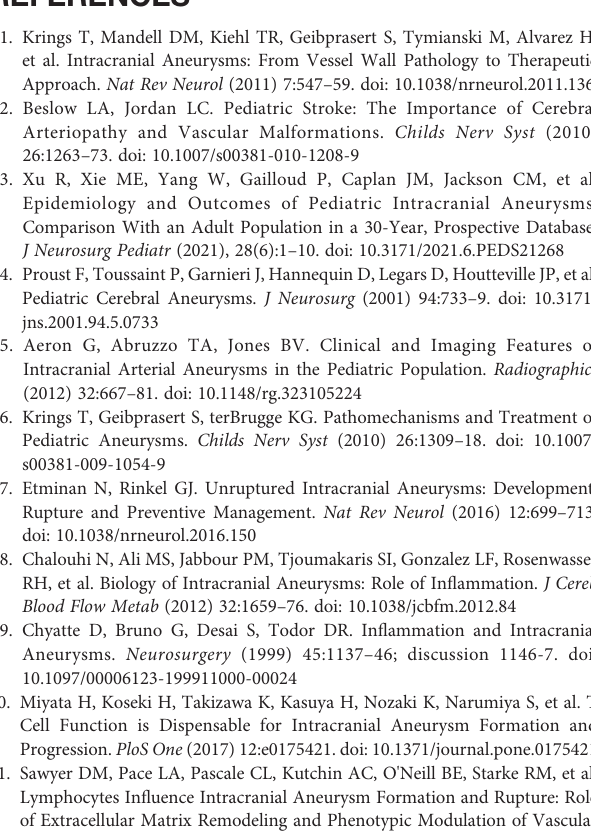
Supplementary Figure 2 | (A) Histograms ofthemarkerexpressionvalues (surface and intracellular differentiation markers analysed ex vivo ) that were used to distinguish cell clusters. Clusters were colored according to the tissue of origin: IA wall (red), PBMCs (green). (B) UMAPs of all analysed markers (as indicated). Blue denotes low, green intermediate and red high expression. (C) Percentages of the nine cell clusters. Supplementary Figure 3 | The temporal order of differentiating cells was inferred by DiffusionMap. DiffusionMap, colored by sample of origin (A) and clusters (B) , showhigherproximityofIAwallT-cellstocirculatingmemoryTcellsascomparedto naïve cells. A general differentiation pattern from naïve phenotypes to memory and TRM in CD4+, CD8+ and DN T-cells can be observed. Supplementary Figure 4 | Gating Strategy used to analyse T cell compartment for CD4+, CD8+ and DN T-cell subsets. Supplementary Figure 5 | (A) CD127 versus CCR7 expression of gated Th1 (CXCR3+ CCR6-), Th1/17 (CXCR3+ CCR6+) and Th17 (CCR6+) were analysed to identify central memory cells (CCR7+CD127+), effector memory (CCR7- CD127+) and effector-like (CD127- CCR7-) cells. (B) To assess the presence of CD27 +CCR6- Tr1-like cells the expression of CD27 and CCR6 was analysed on gated CD4+ CD25- CD127- CCR5+ T-cells. (C) Gating Strategy used to analyse CD4+ effector-like T-cells (CD127 lo FOXP3-). Supplementary Figure 6 | (A) Histograms of the marker (cytokines and differentiation markers) expression values were used to distinguish cell clusters followingbriefpolyclonal stimulation.Clusterswerecoloredaccordingtothesample of origin: IA_WALL (red), PT_PBMCs and IA_WALL (yellow), PBMCs (blue) and ALL (shared among all tissue, violet). (B) UMAP of all analysed markers, as indicated. Blue denotes low, green intermediate and red high expression. (C) Frequencies of all cell clusters among T-cells in each sample as